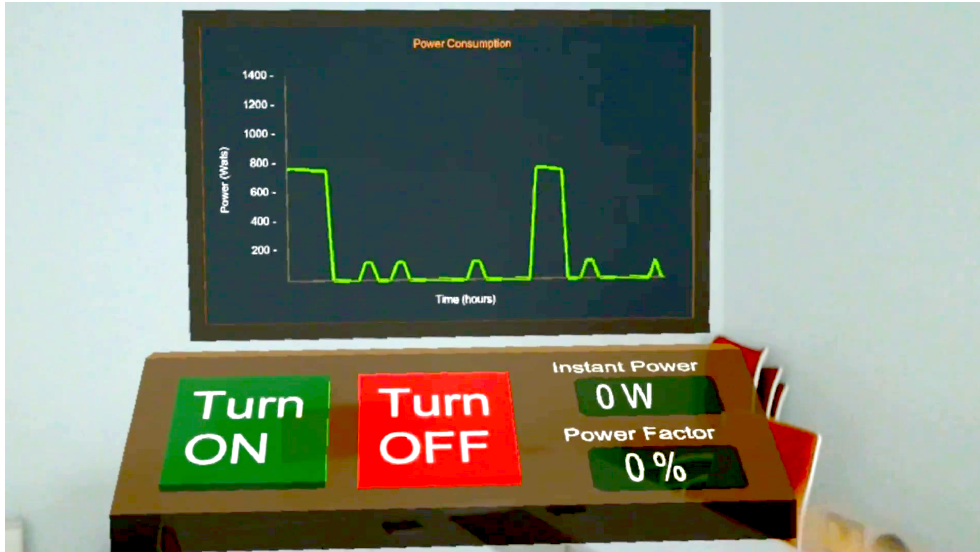
Figure 8. Virtual dashboard for controlling and monitoring the smart